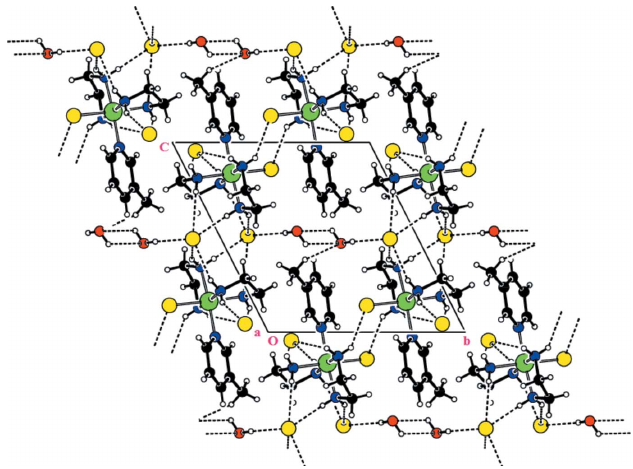
Figure 3 A partial of the crystal packing of the title compound, showing an R 2 motif formed via an inversion-related pair of O—H (cid:2)(cid:2)(cid:2) O hydrogen bonds (dashed lines).